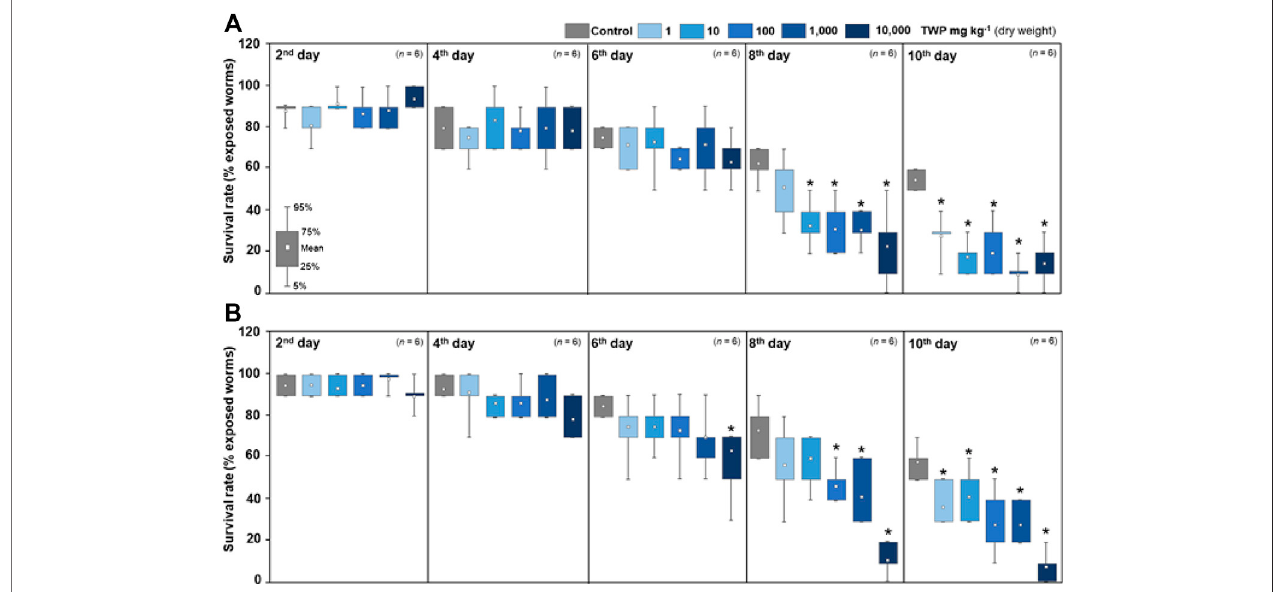
FIGURE3| Survivalratesof C.elegans afterthelifetimeexposuretests.Thelifetimeexposuretestswereperformedaftertwodifferentsoilpre-incubationtimes: (A) nopre-incubationand (B) 75 days.Thesurvivalrate(%)wascalculatedtoinitiallyexposednematodesatevery2 daysuntil10thdayafter fi rstexposure.Theasterisks(*) indicate signi fi cant ( p < 0.05) differences compared to the control treatment